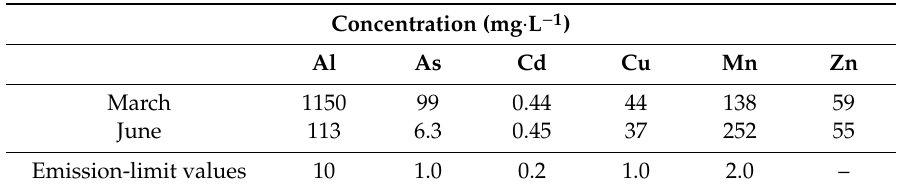
Table 3. Tailings leachate concentrations from Cabeço do Pi ã o dam [23] in comparison with admissible values in Portuguese legislation (Decret-Law n ◦ 236 / 98, 1 August 1998)